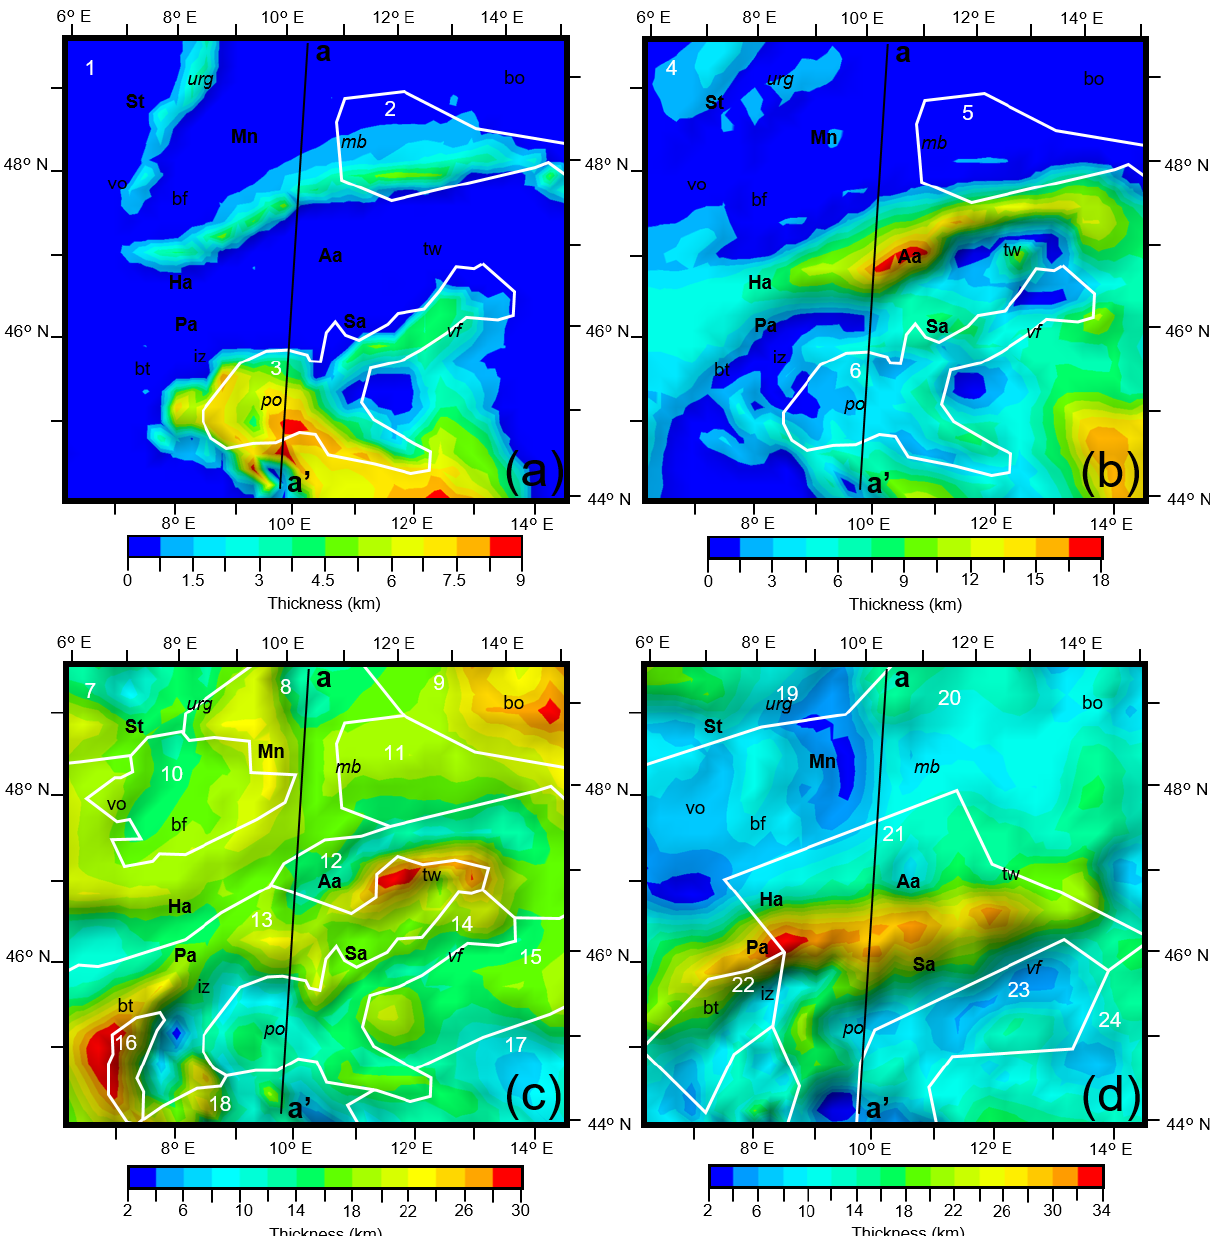
Figure 4. Thickness of (a) unconsolidated sediments, (b) consolidated sediments, (c) the upper crust, and (d) the lower crust across the modelled area. Density domains required during modelling within the layer are overlaid in white; domain numbers are shown in white and correspond to Table 1. Locations of key tectonic features are overlaid (abbreviations shown in Fig. 1a